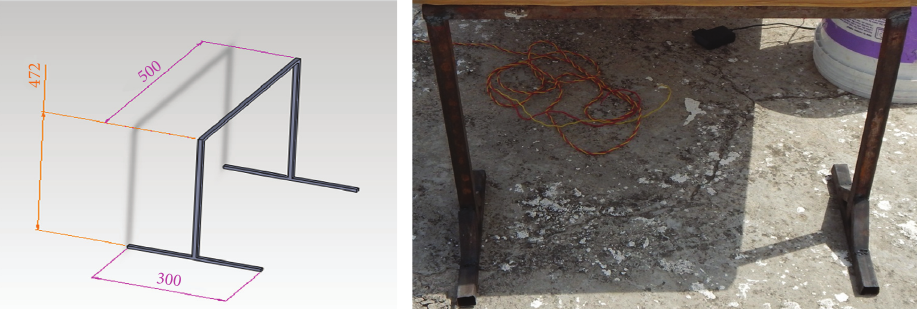
Figure 5: Stand used in the solar dryer. Table 2: Class material size and material.